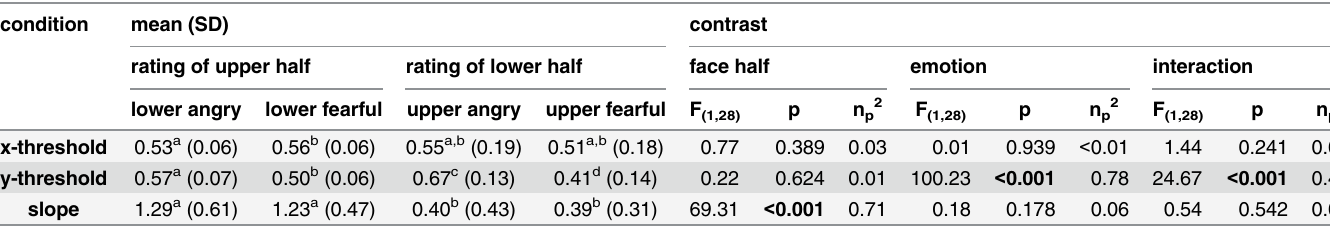
Table 2. Comparison of curve parameters for experiment 2.